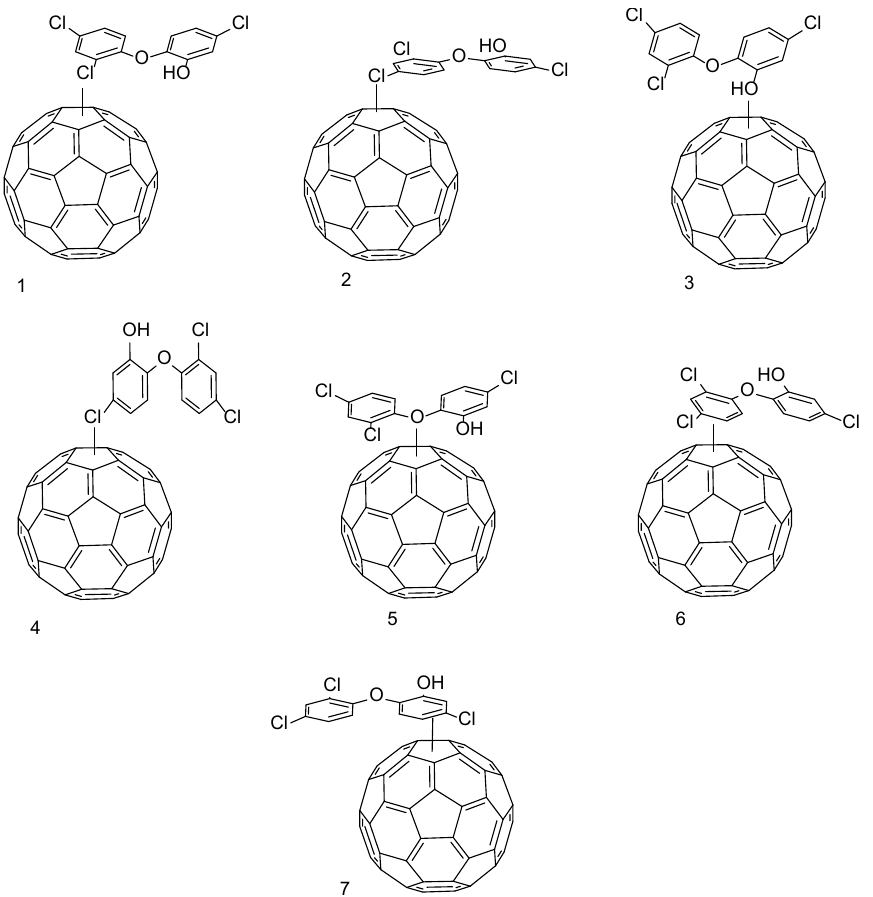
Fig. 6. Triclosan-C60 complexes in different active sides (seven different position) Table 3. Electronic parameters of triclosan in gas and water phase by B3LYP/6-311++G(2d,2p)